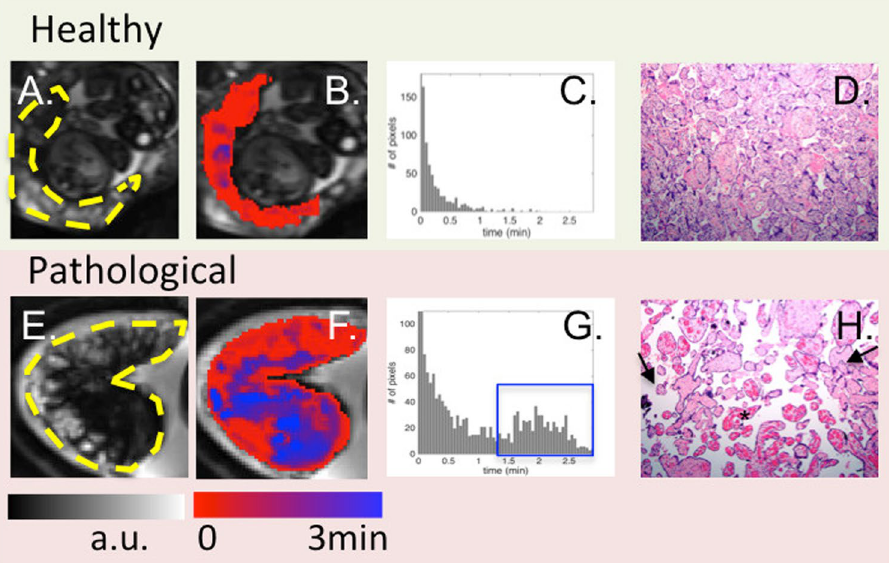
Figure 3. From left to right: BOLD images, TTP maps, histogram of TTP distribution and histology (10X). One control (top) is compared to one case with abnormal placental pathology (bottom). Yellow dashes in A and E outline the placenta. For healthy subjects, TTP values were short and placental histology was normal. For pathological cases, TTP values were longer and less uniform (blue regions in ( F ) and blue box in ( G )). Arrows in H point to avascular villi and the star identifies chorangiosis.